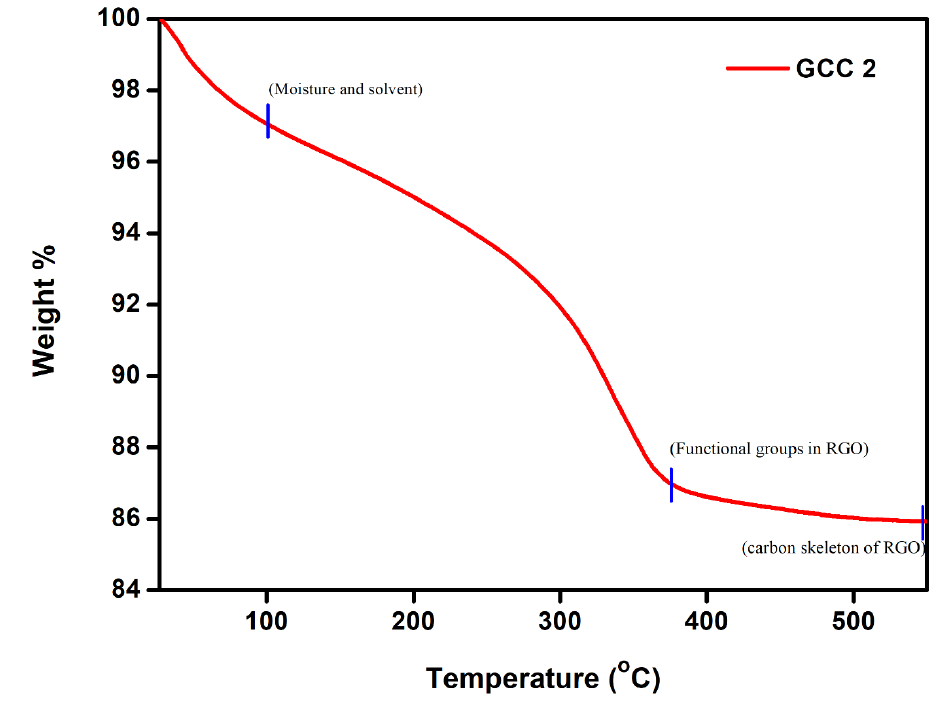
Figure 5. TG curve of GCC 2.